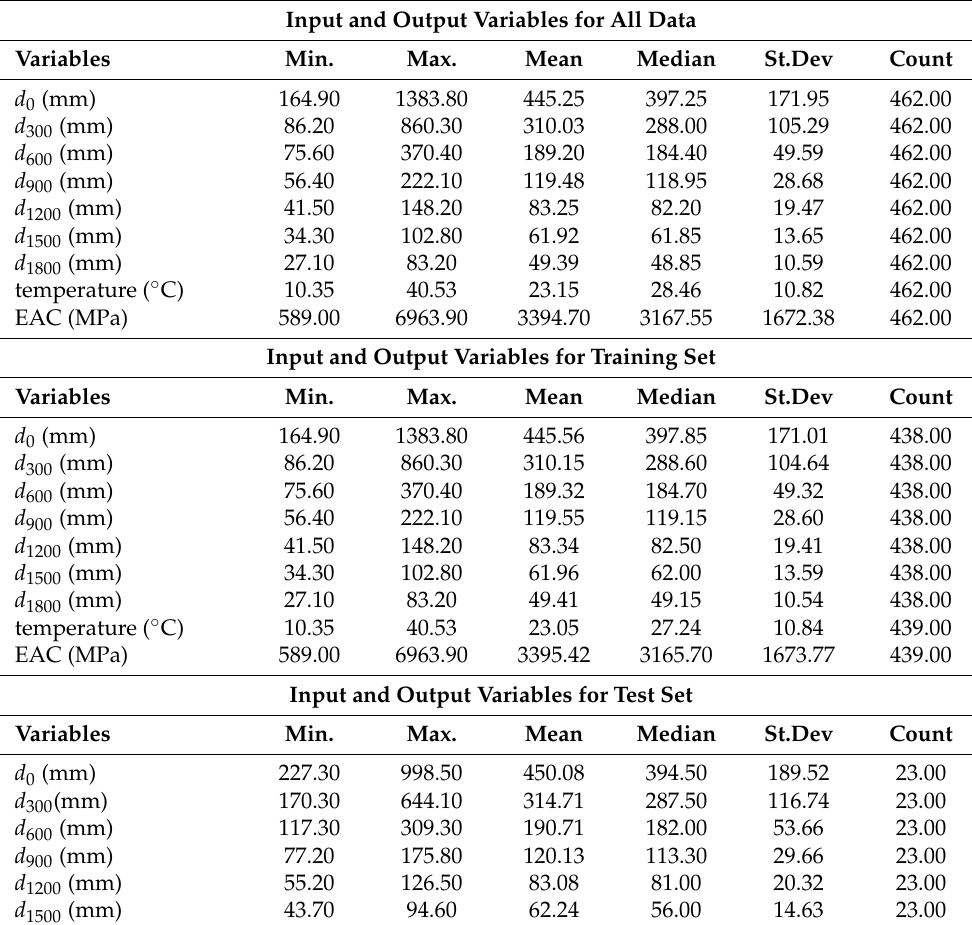
Table 3. Statistical analysis of variables used for ANN, SVM and BRT